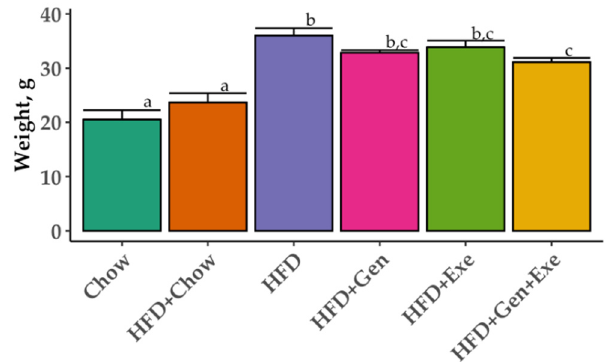
Figure 2. Mean ± SE weight gain (g) over 24 weeks of six different dietary and exercise interventions. Treatment groups are as follows: unpurified diet (chow); high-fat, high-sugar diet + chow (HFD + chow); HFD; HFD + exercise (HFD + Exe); HFD + genistein (HFD + Gen); HFD + Exe + Gen. Significant group differences ( p < 0.05) by one-way analysis of variance (ANOVA) test after Tukey post-hoc pairwise comparison. Different letters denote significant differences.